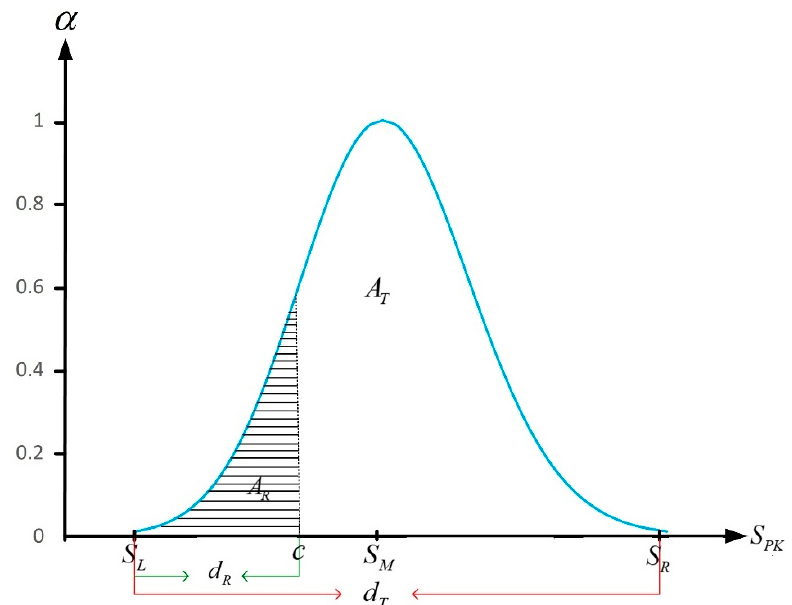
Figure 1. Membership functions of η ( x ) with x = c and c ≤ S M .